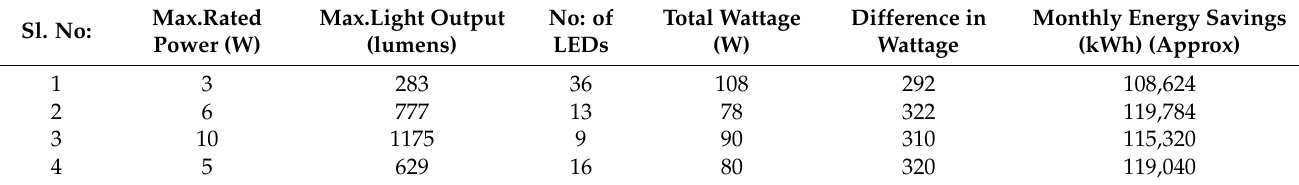
Table 2. Design of discrete LED lamps with the corresponding energy